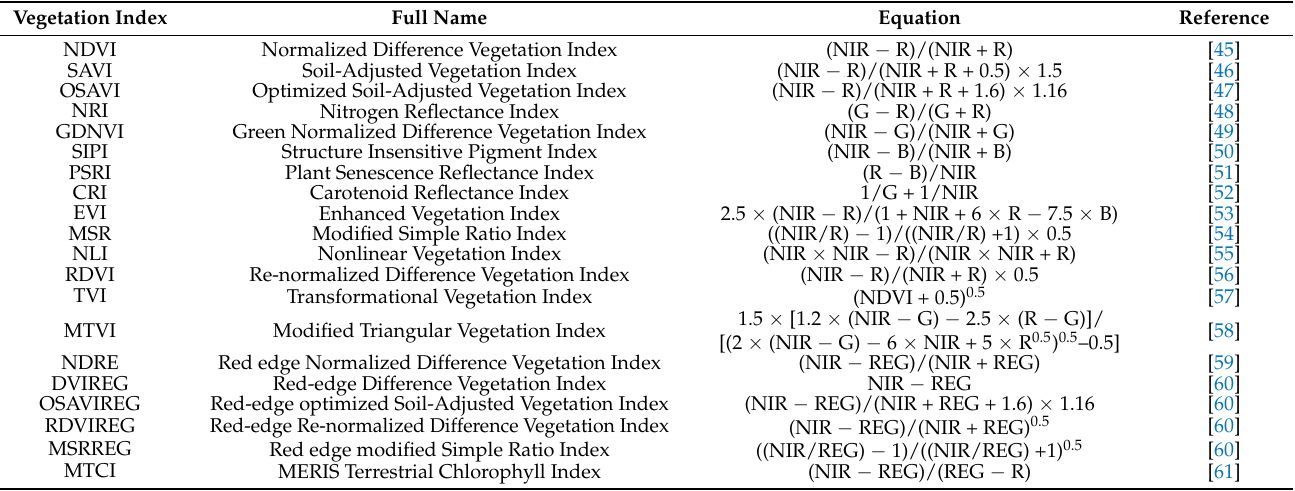
Table 3. Introduction of the multispectral vegetation